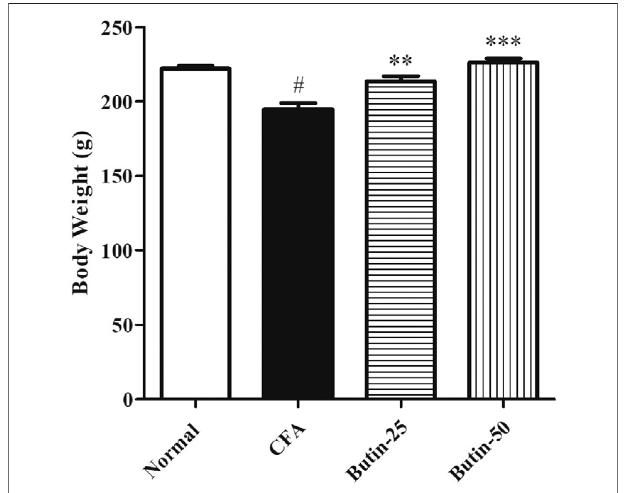
FIGURE 2 | Effect of butin on body weight in CFA-treated rats. Values are expressed in mean ± SEM ( n = 6). # p < 0.05 vs. normal control rats and